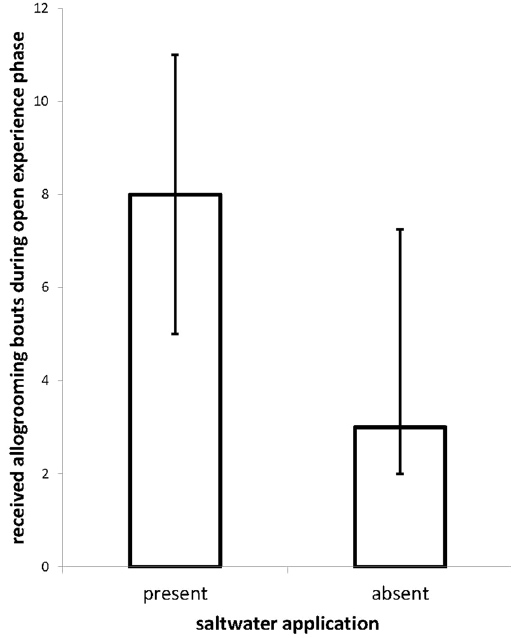
Figure 2. Experience phase. Focal rats received more grooming bouts during the open experience phase in which their partners could freely interact with them after saltwater had been applied onto their neck compared to when no saltwater had been applied in this phase. Median grooming frequencies ± interquartile ranges are depicted per 20 min observation